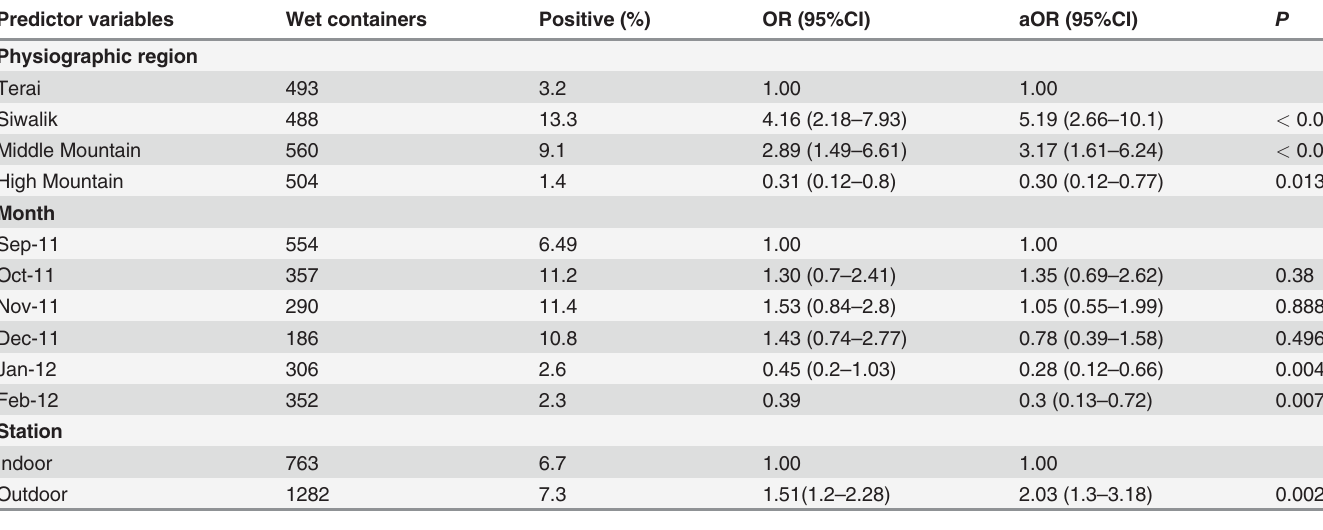
Table 4. Multivariate logistic regression analysis for the presence of Aedes albopictus larvae and pupae. Predictor